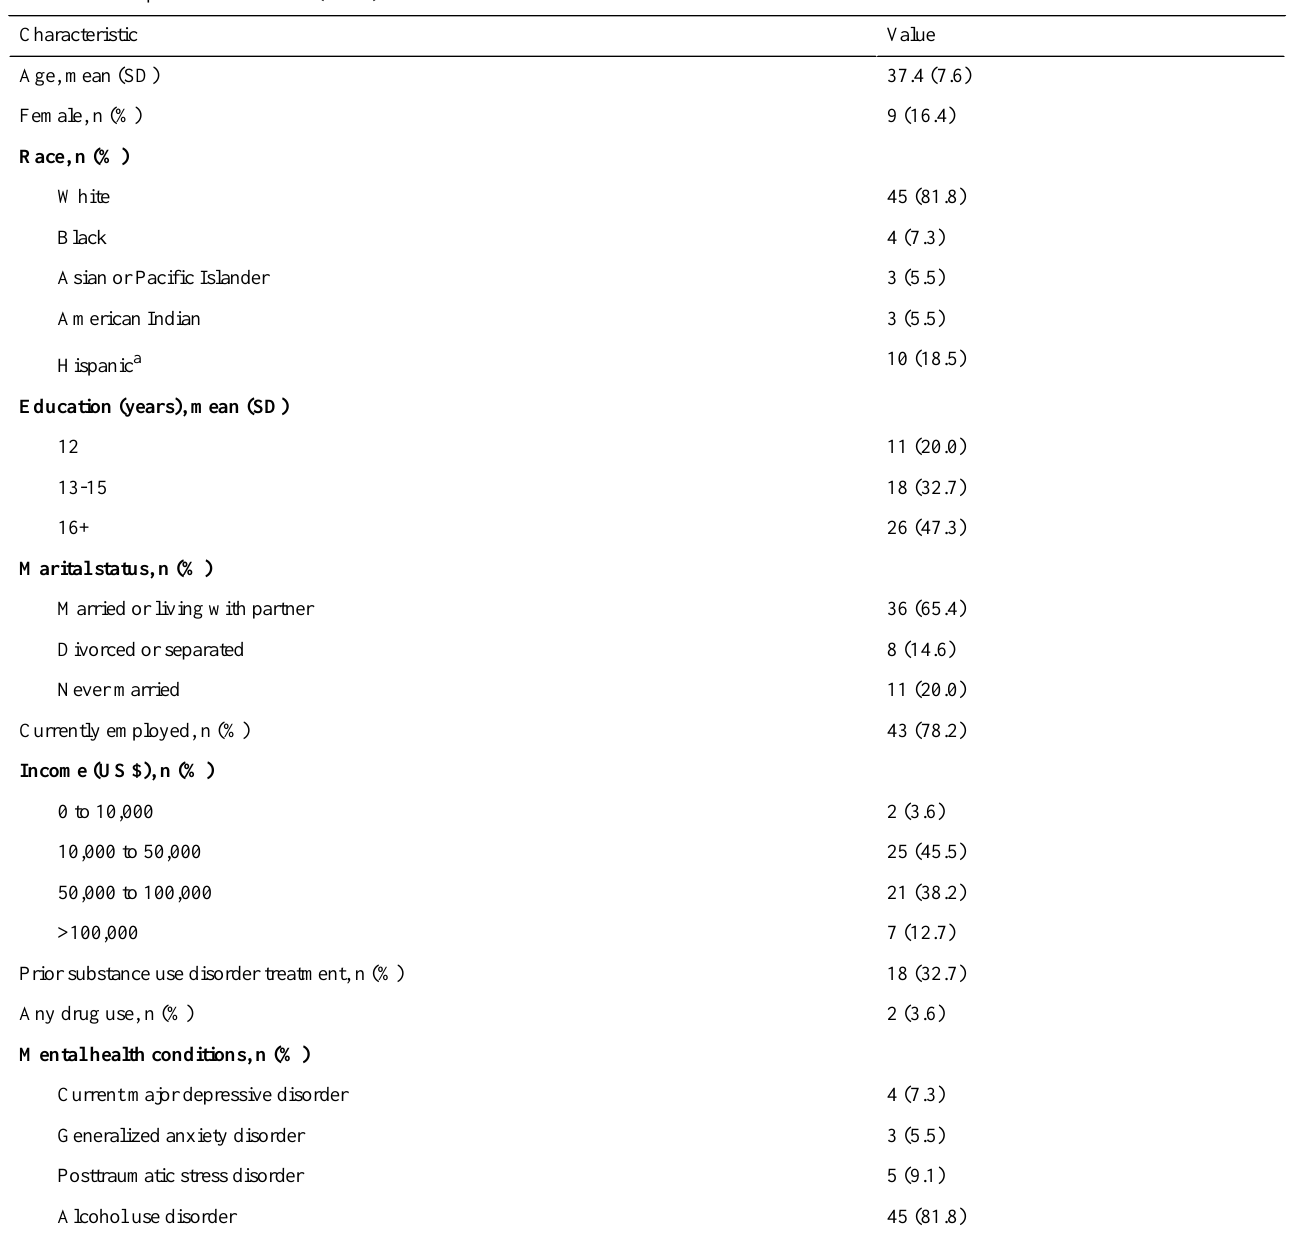
Table 1. Participant characteristics